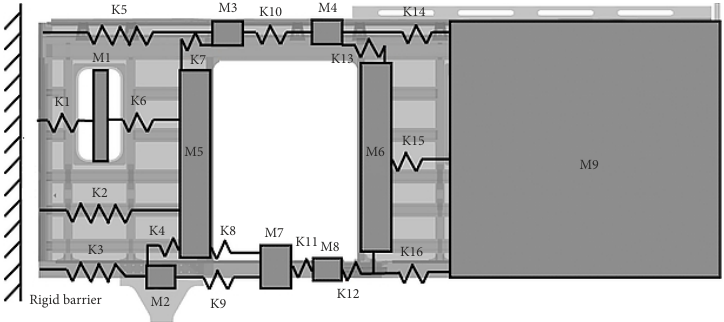
Figure 22. Complete vehicle spring-mass structural parametric